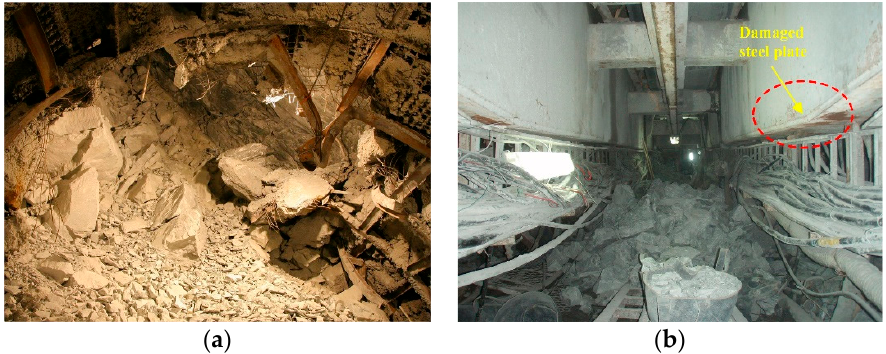
Figure 2. Rockburst in auxiliary tunnels: ( a ) Extremely strong rockburst; ( b ) induced collapse and ( c ) support structure damage.